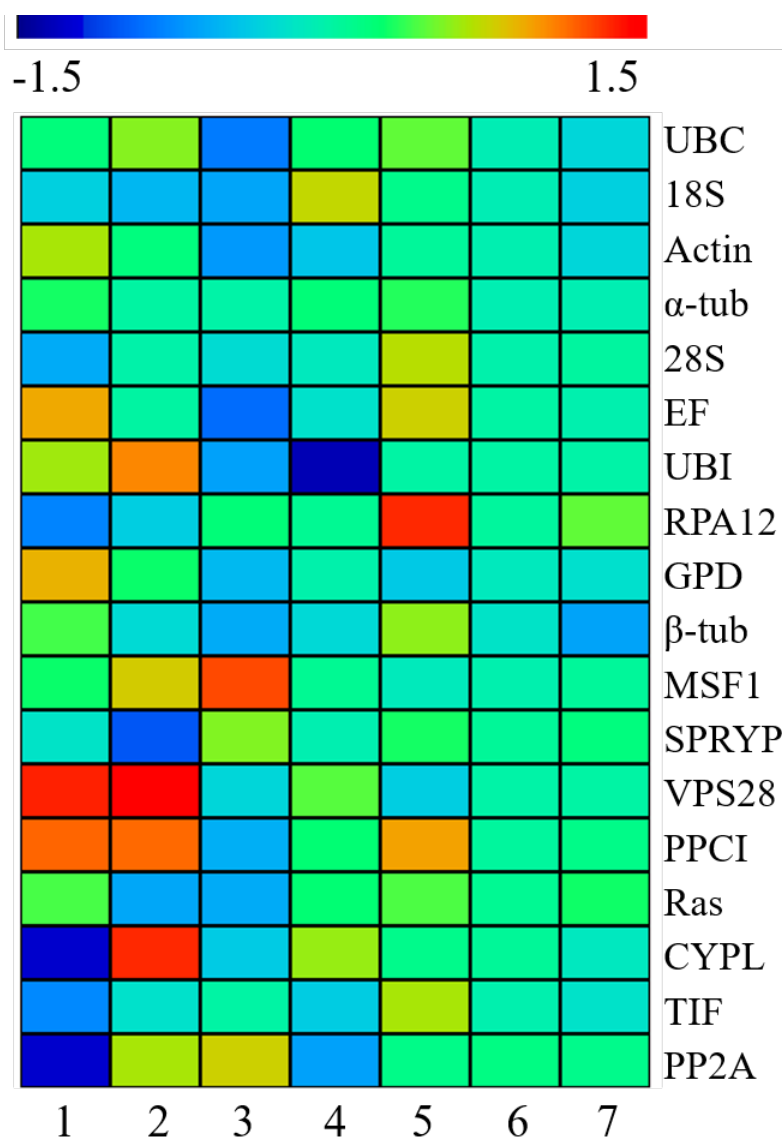
Figure 4. Heat map (log 2 fold change) showing expression stability of eighteen candidate reference genes in different L. edodes strains under different conditions. ( 1 and 2 ) heat stress/control in YS3357 and S606; ( 3 and 4 ) Trichoderma atroviride stress/control in YS3334 and YS55; ( 5 and 6 ) cellulose/glucose and cellulose+ sodium lignosulphonate/glucose in WX-1. 7, Light treatment/control in L135. Red, Upregulation. Blue, Downregulation. Scale bar is given at the top of the heat map.